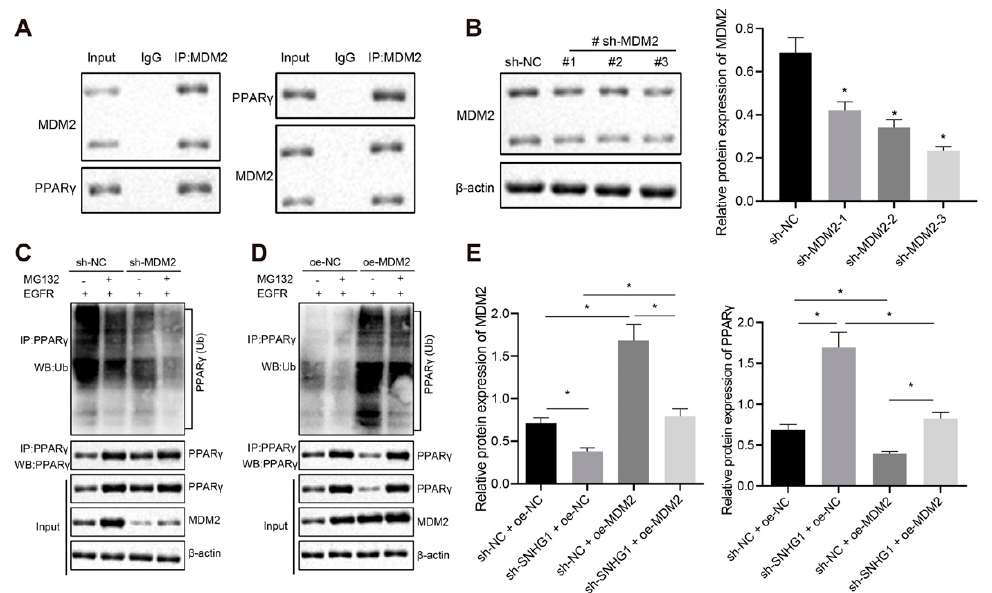
Figure 8. Silencing of SNHG1 decreases PPAR γ ubiquitination and enhances PPAR γ expression via MDM2. ( A ) The binding of MDM2 to PPAR γ detected by IP assay in T24 cells. ( B ) Western blot analysis of the expression of MDM2 and screening of a shRNA sequence with the highest silencing efficiency. ( C ) IP assay detecting the change of PPAR γ ubiquitination after silencing MDM2. ( D ) IP assay detecting the change of PPAR γ ubiquitination after overexpressing MDM2. ( E ) MDM2 and PPAR γ expression detected by Western blot analysis after overexpressing MDM2 and silencing SNHG1 in T24 cells. * p < 0.05. The cell experiment was repeated three times. Data were presented as mean ± standard deviation and compared by one-way analysis of variance.